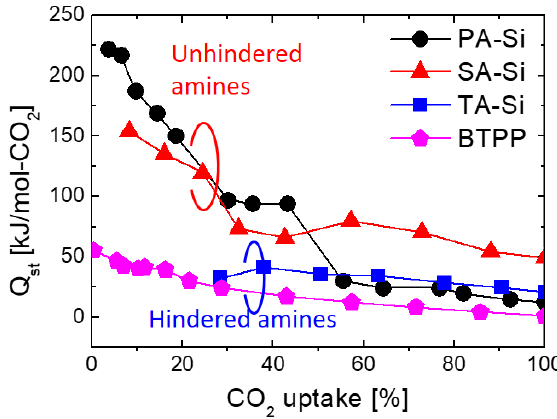
Figure 11. Isosteric adsorption heat of CO 2 for amine-functionalized organosilica xerogel powders calculated from adsorption isotherms. Adsorption isotherms measured at 35, 45 and 55 °C were adopted for the calculation and the values of CO 2 uptake were normalized using each maximum adsorption capacity (at 100 kPa) as a standard. Results were reorganized form refs. [21,22].